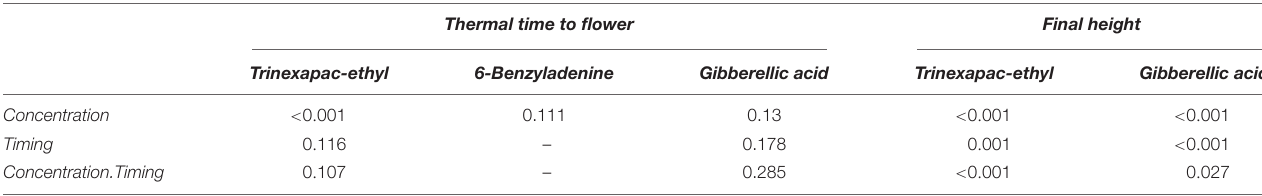
TABLE 4 | The significance of concentration, timing and their interaction on the thermal time to flowering and final height in Spartacus CL after spray applications of trinexapac-ethyl, 6-benzyladenine, and gibberellic acid.